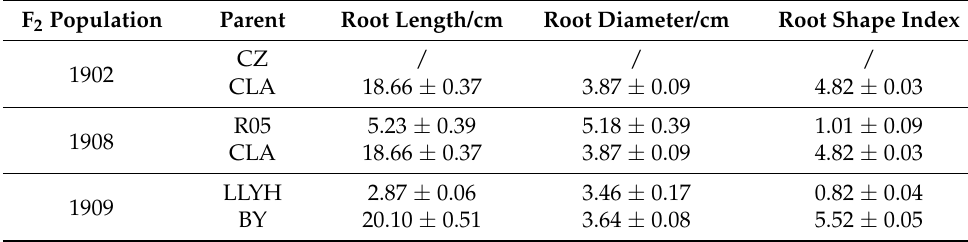
Figure 1. Roots of the parents at their corresponding complete growth periods and the roots of individuals with extreme phenotypes at 45 d of growth. ( a ) Parents of the CZ × CLA cross and extreme individuals from the 1902 population. ( b ) Parents of the R05 × CLA cross and extreme individuals from the 1908 population. ( c ) Parents from the LLYH × BY cross and extreme individuals from the 1909 population. Table 1. Phenotypic data of the parents at 45 days of growth. Three biological replicates were recorded.